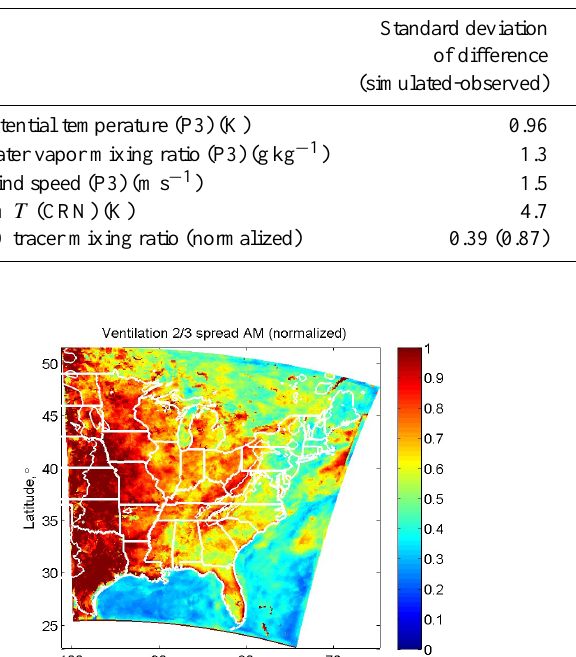
Table 7. Spread and standard deviation statistics for all WP3 aircraft flights below 1000ma.s.l. and for CRN 2m temperature. Model points are extracted along the flight track every 10s, linearly interpolated in space and time, and then averaged over 120s. CRN 2m temperature statistics are for all available hourly observations ( N = 33569). N = 2026 for P3 meteorology; N = 1597 for P3 CO. Columns are: standard deviation of simulated minus observed value, full spread of the ensemble (highest minus lowest member at each point), spread of the inner four of the six ensemble members (i.e., 2/3 spread), standard deviation of the observation, and standard deviation of the ensemble mean. CO spreads and simulated CO standard deviation are normalized by the simulated ensemble mean. Observed CO standard deviation is normalized by the observed mean with minimum value subtracted to account for background. For simulated–observed standard deviation of CO, two values are shown; the smaller is normalized by the observed mean with minimum subtracted (71ppb) and the larger is normalized by the simulated mean (32ppb).